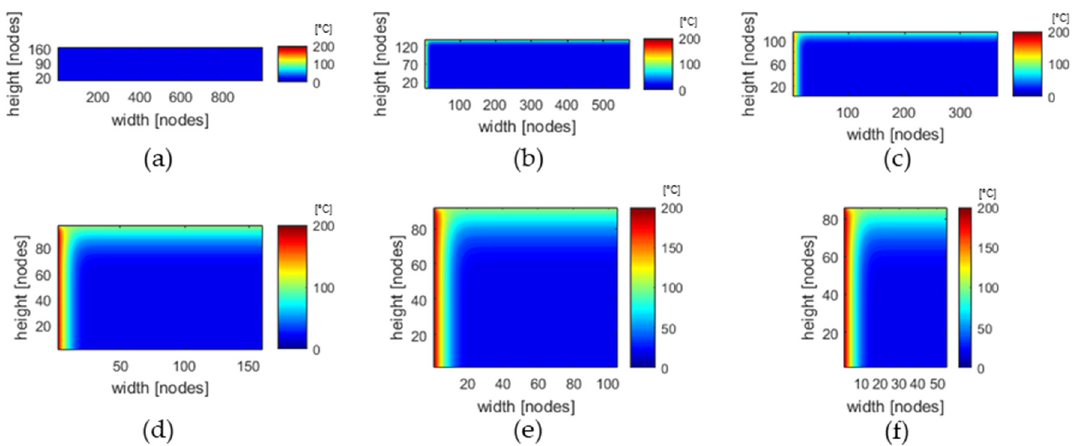
Figure 15. Temperature of solid bed of an D = 60 mm extruder with a three-section screw at axial position ( a ) 9 D, ( b ) 13.5 D, ( c ) 16 D, ( d ) 18.2 D, ( e ) 18.8 D, ( f ) 19.5 D. The nodes are equidistant for ( a )–